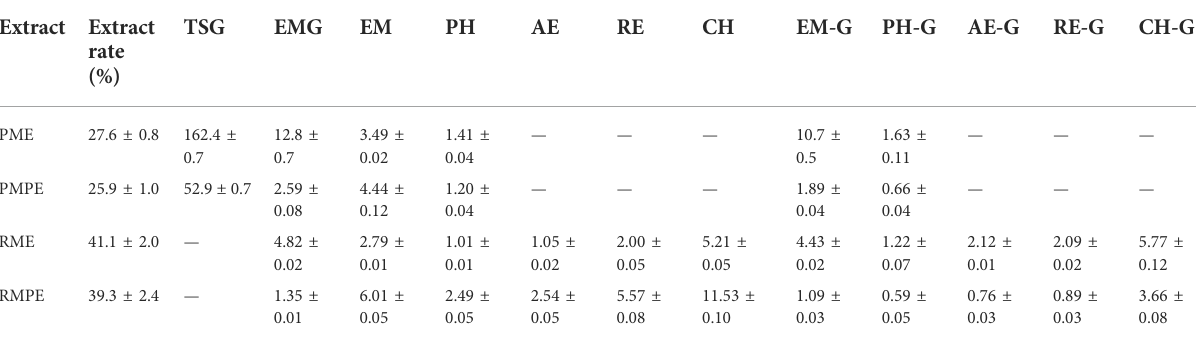
TABLE 1 The contents of key components in PM, rhubarb and their concocted herbal extracts ( μ g/mg, mean ± SD, n = 2). Extract Extract rate